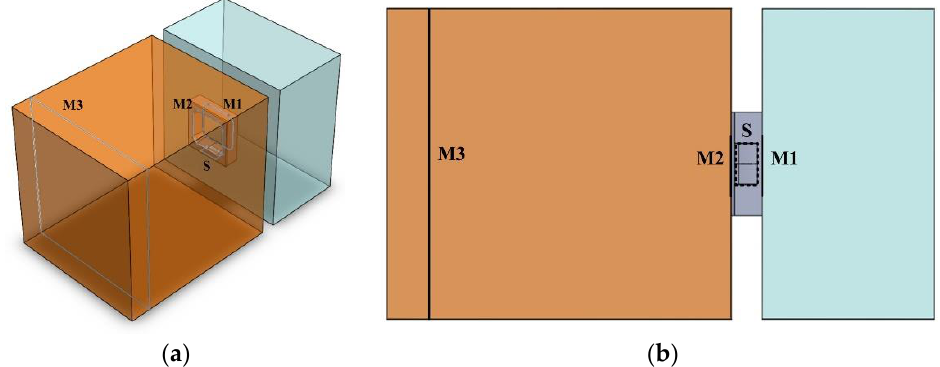
Figure 9. Relative positions of numerically measured planes in the analysis model. ( a ) 3D view, and ( b ) bottom view.